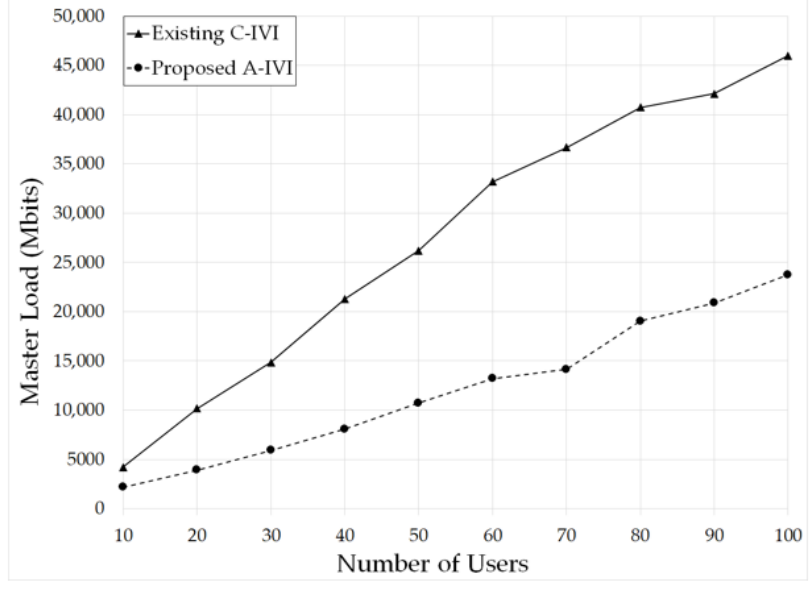
Figure 28. Master load for different number of users.